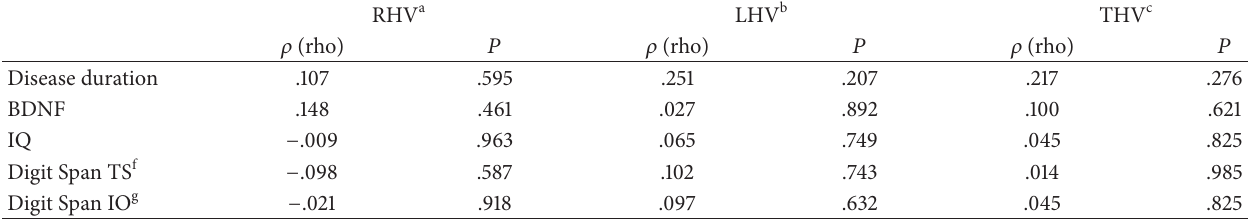
Table 4: Correlations between levels of BDNF, hippocampal volume, and neuropsychological measures.